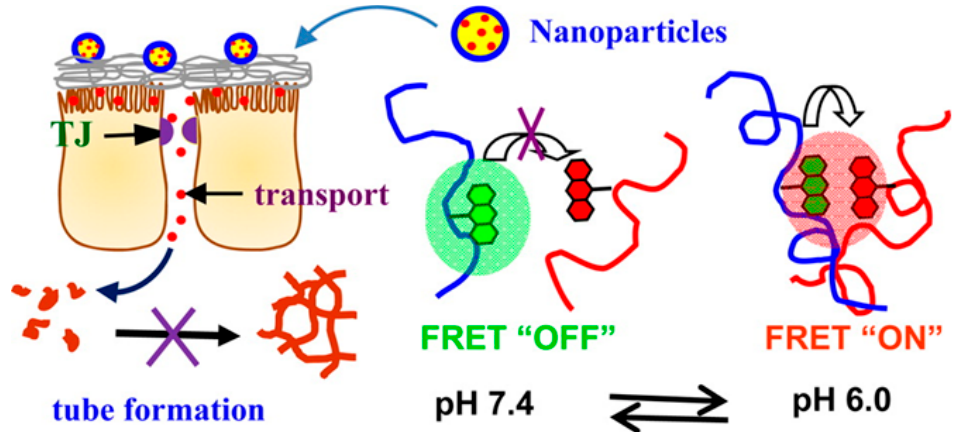
Figure 12. Schematic representation of dual emission and pH-responsive mediated drug release of FRET-based smart nanocarrier. Reproduced with permission from [189]. Copyright 2014, American Chemical Society.